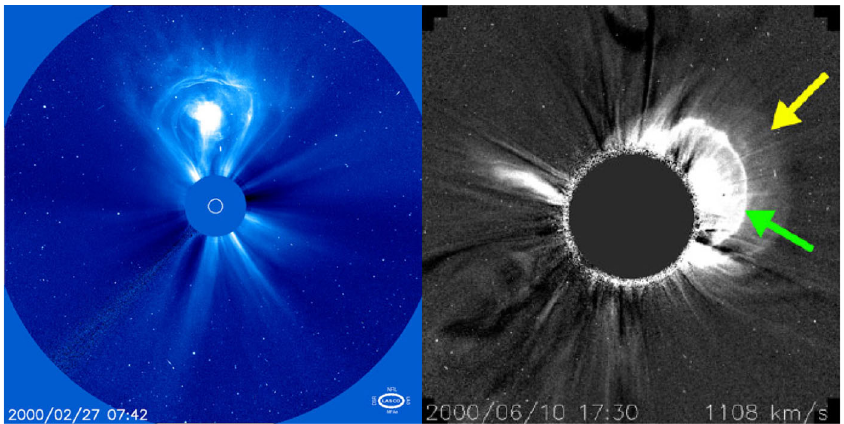
Fig. 11 (Left) A CME with a classical three-part structure detected one February 27, 2000 in SOHO/LASCO C3 image (Image courtesy: NASA). (Right) An excess mass image illustrating two more signaturesofafive-partCMEonJune10,2000inSOHO/LASCOC2image.Theyellowarrowindicatesthe sharp edge (shock) and the green arrow the bright front. Image reproduced by permission from Vourlidas et al. (2013), copyright by